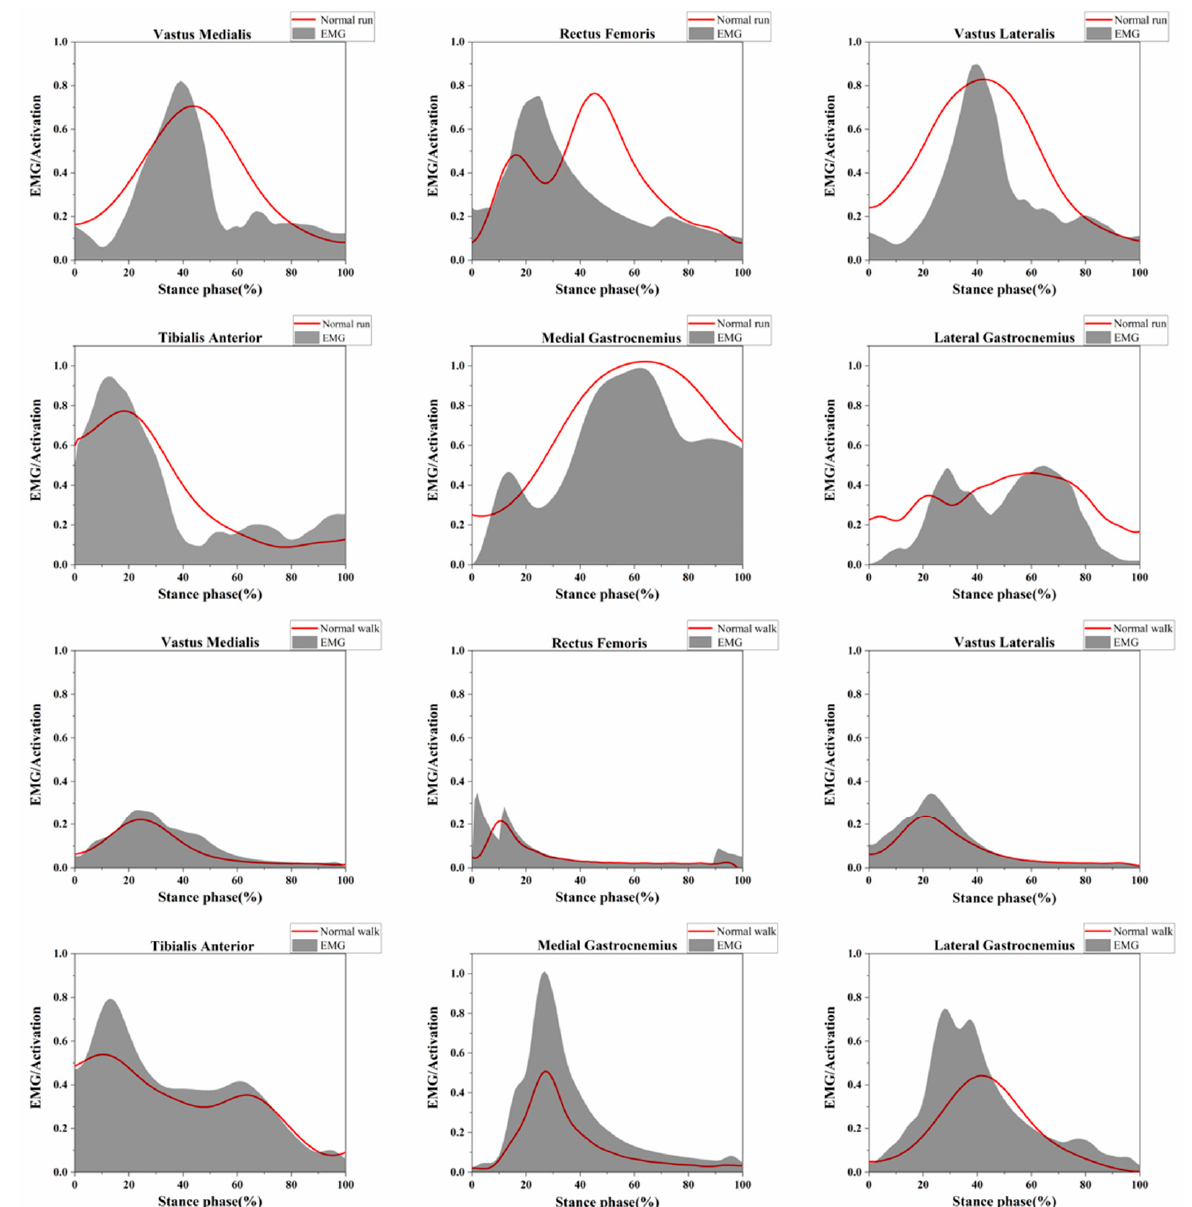
Figure 3. Illustration of the EMG/activation of each muscle. The scale on the left of each image represents that 0 (no activity) to 1 (full activity). The scale on each image below represents a stance phase from 0 to 100. Grey shaded areas represent the results of activation from EMG. Red lines represent the results of activation from musculoskeletal modeling.